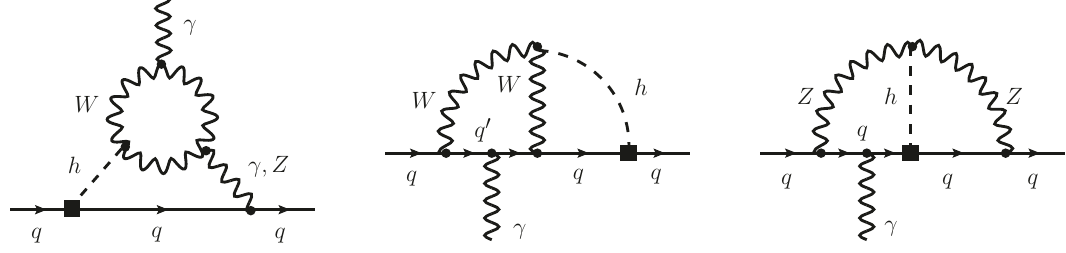
Figure 3 . Sample two-loop Feynman diagrams with internal gauge bosons, inducing an electric dipole moment for the light quark q = u; d; s .